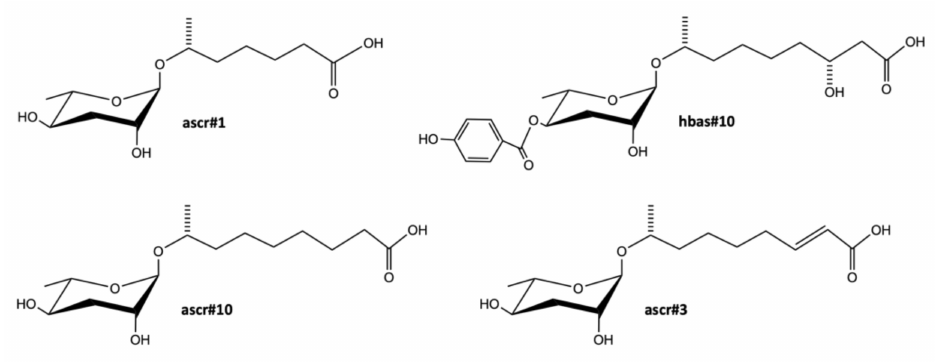
Figure 1. Example of ascaroside-structures: ascr#1, hbas#10, ascr#10 and ascr#3. Srinivasan et al. used activity guided fractionation, 2D-NMR and targeted LC-MS measurements to identify mating signals, which were excreted by L4, YA and adult hermaphrodites. Three ascarosides called ascr#2, ascr#3 and ascr#4 were identified and the attraction seemed to be concentration dependent. While males were attracted at low concentrations, deterrence occurred at higher concentrations [49]. Further